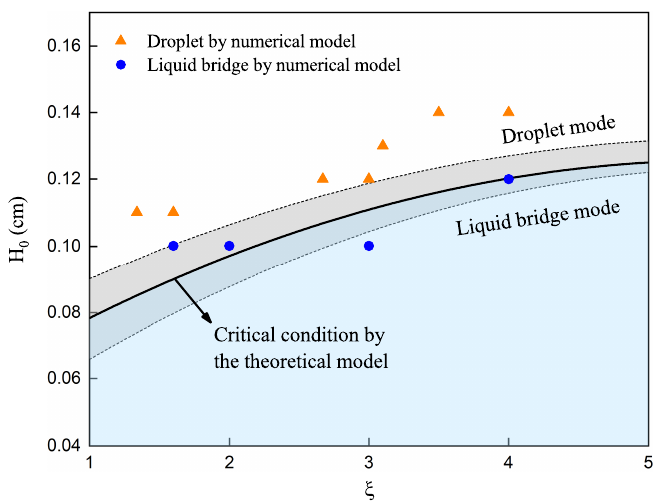
Figure 10. Process parameter window considering liquid bridge–droplet